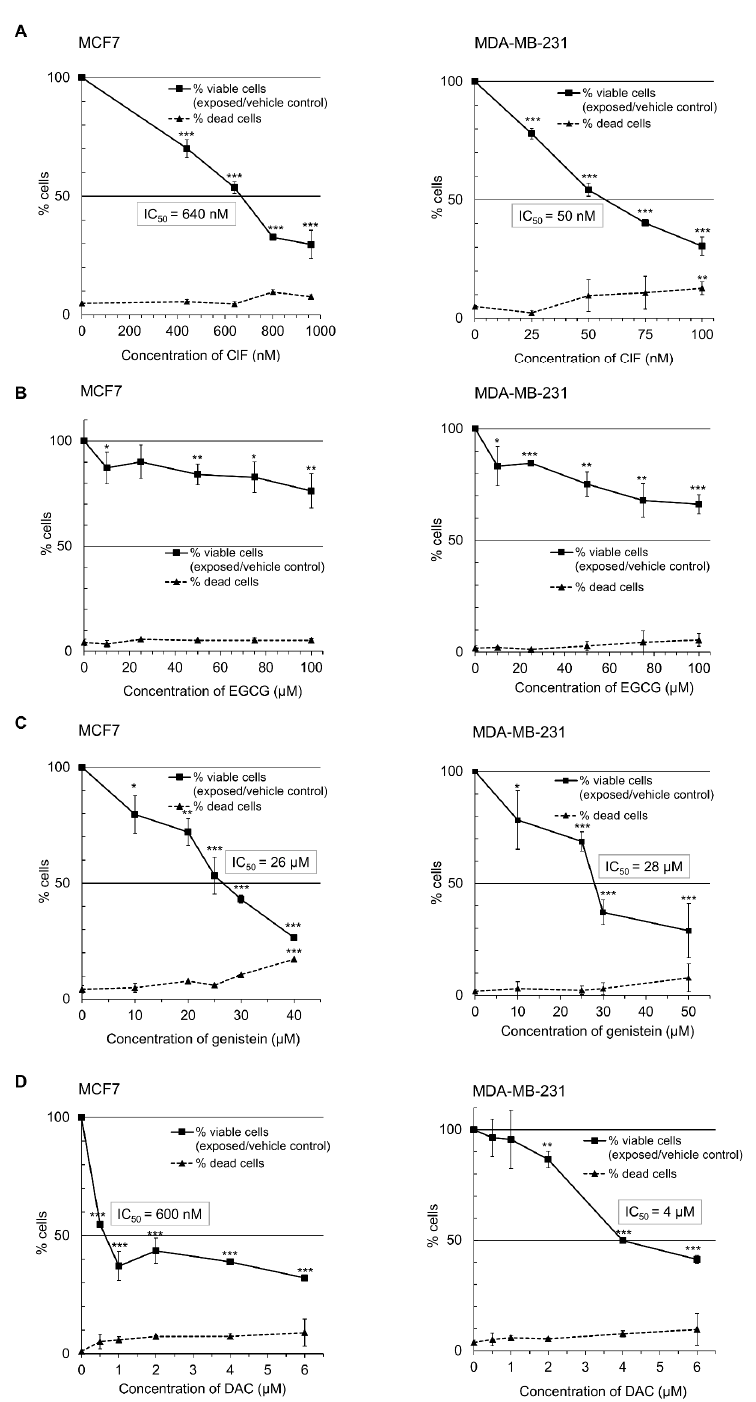
Figure 1. Effect of ClF ( A ), EGCG ( B ), genistein ( C ), and DAC ( D ) on MCF7 (left panel) and MDA-MB-231 (right panel) cell viability as measured by trypan blue exclusion test. MCF7 and MDA-MB-231 breast cancer cells were incubated for 4 days with the tested compounds at the indicated concentrations. The number of viable cells after 4 days exposure to ClF, genistein, and DAC at IC 50 concentrations (IC 50 not achieved for EGCG) was expressed as a percentage of viable cells in the vehicle control ((viable exposed/viable vehicle control)*100%). The number of dead cells in either vehicle control or exposed group was calculated as a percentage of the total cell number. DAC was used as a positive control in the trypan blue exclusion test. Values are means ± SD of at least three independent experiments. Exposure (ClF alone or EGCG alone or genistein alone or DAC alone) versus vehicle control, *** p < 0.001, ** p < 0.01, * p < 0.05.